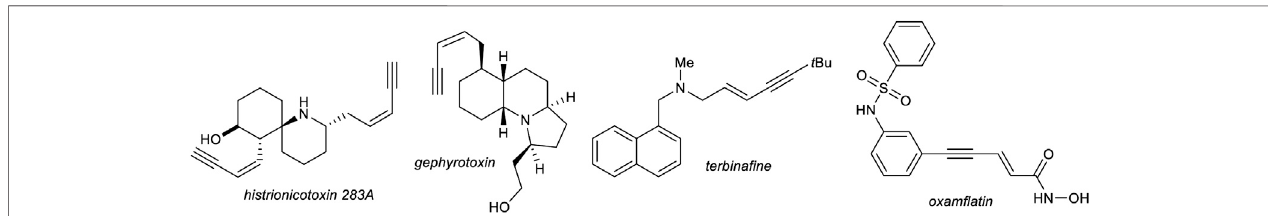
Frontiers in Chemistry |